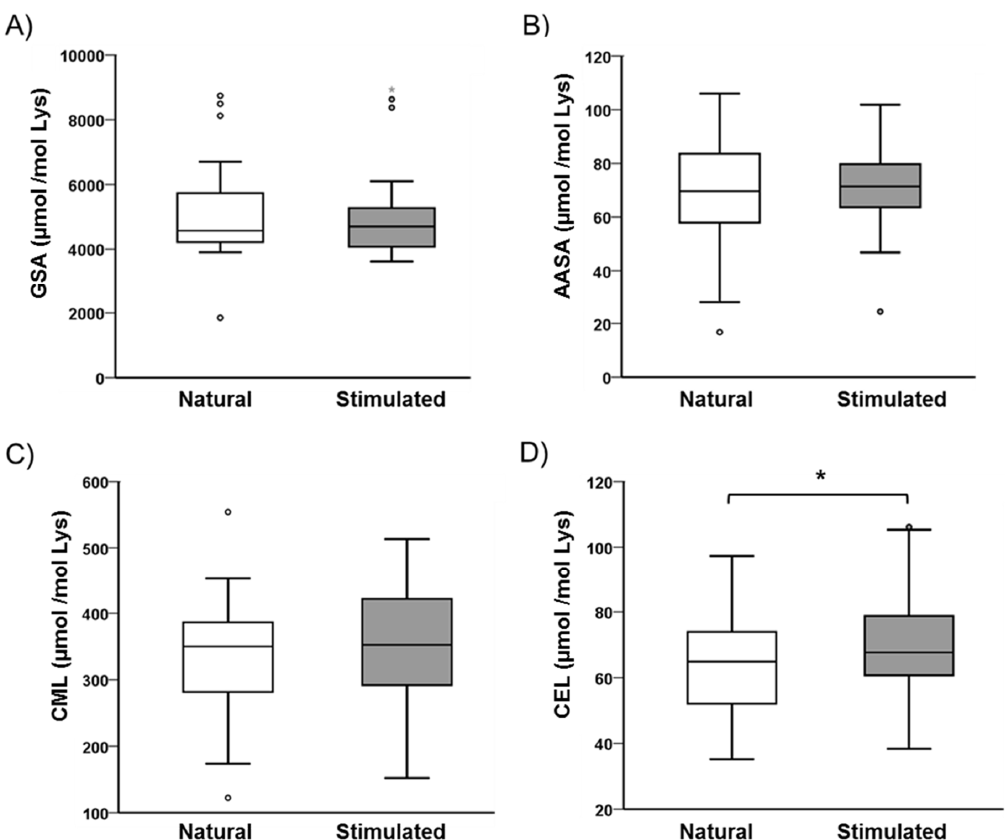
Figure 4. Biomarkers of protein oxidative modifications in follicular fluid from women undergoing both a natural cycle and a stimulated cycle. The box and whiskers graphs represent values for ( A ): GSA; ( B ): AASA; ( C ): CML; and ( D ): CEL. The box extends from the 25th to 75th percentiles. The line in the middle of the box corresponds to the median, and the whiskers are drawn down to the 5th percentile and up to the 95th percentile. Open circles represent the outliers of the distribution. Values are expressed as μmol biomarker/mol Lys residue. * p < 0.05.